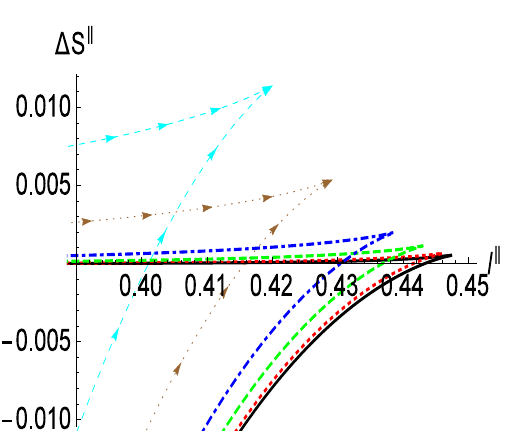
Figure 9 . (cid:1) S k as a function of ‘ k for var- ious B , with ‘ c = 0 : 2. Here c = 0 : 3 and (solid, black), (dot, red), (dash, green), (dot- dash, blue), (arrow-dot, brown) and (arrow- dash, cyan) curves correspond to B = 0, 0 : 1, 0 : 2, 0 : 3, 0 : 5 and 0 : 7 respectively. In units GeV.